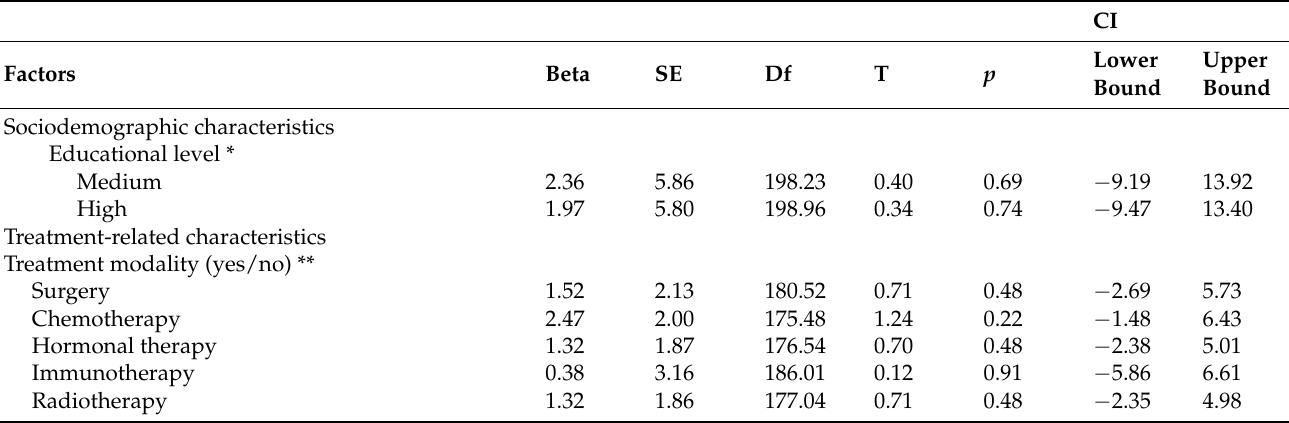
Table 3. Explanatory factors of the trajectory of cognitive functioning of the total